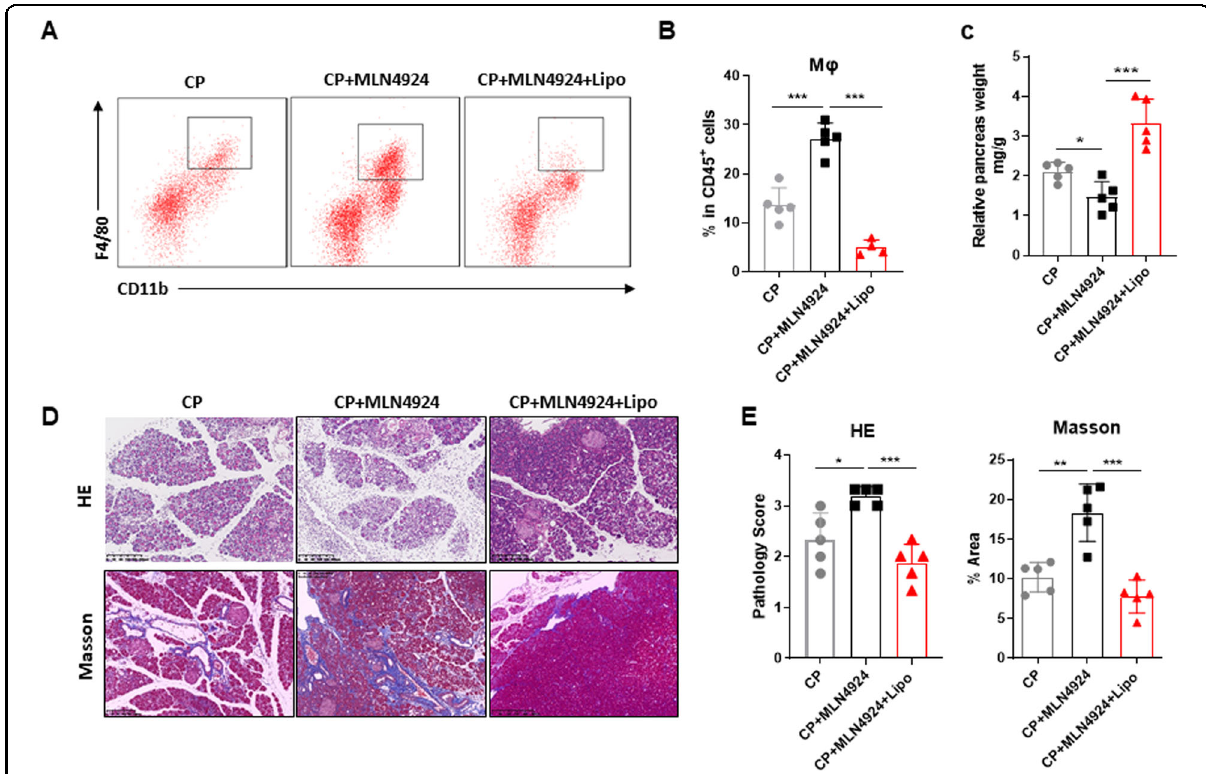
Fig. 3 Neddylation inactivation promotes pancreatitis in a macrophage-dependent manner. A , B Representative fl ow cytometric fi gures and percentages of macrophages in pancreata from different groups of mice. C Relative pancreas weight (pancreas weight/body weight). D Representative H&E and Masson images of pancreata. Scale bar, 200 μ m. E Bar graphs of D . A – E n = 5. Data are representative of three independent experiments. *p < 0.05, ** p < 0.01, *** p < 0.001, ns no signi fi